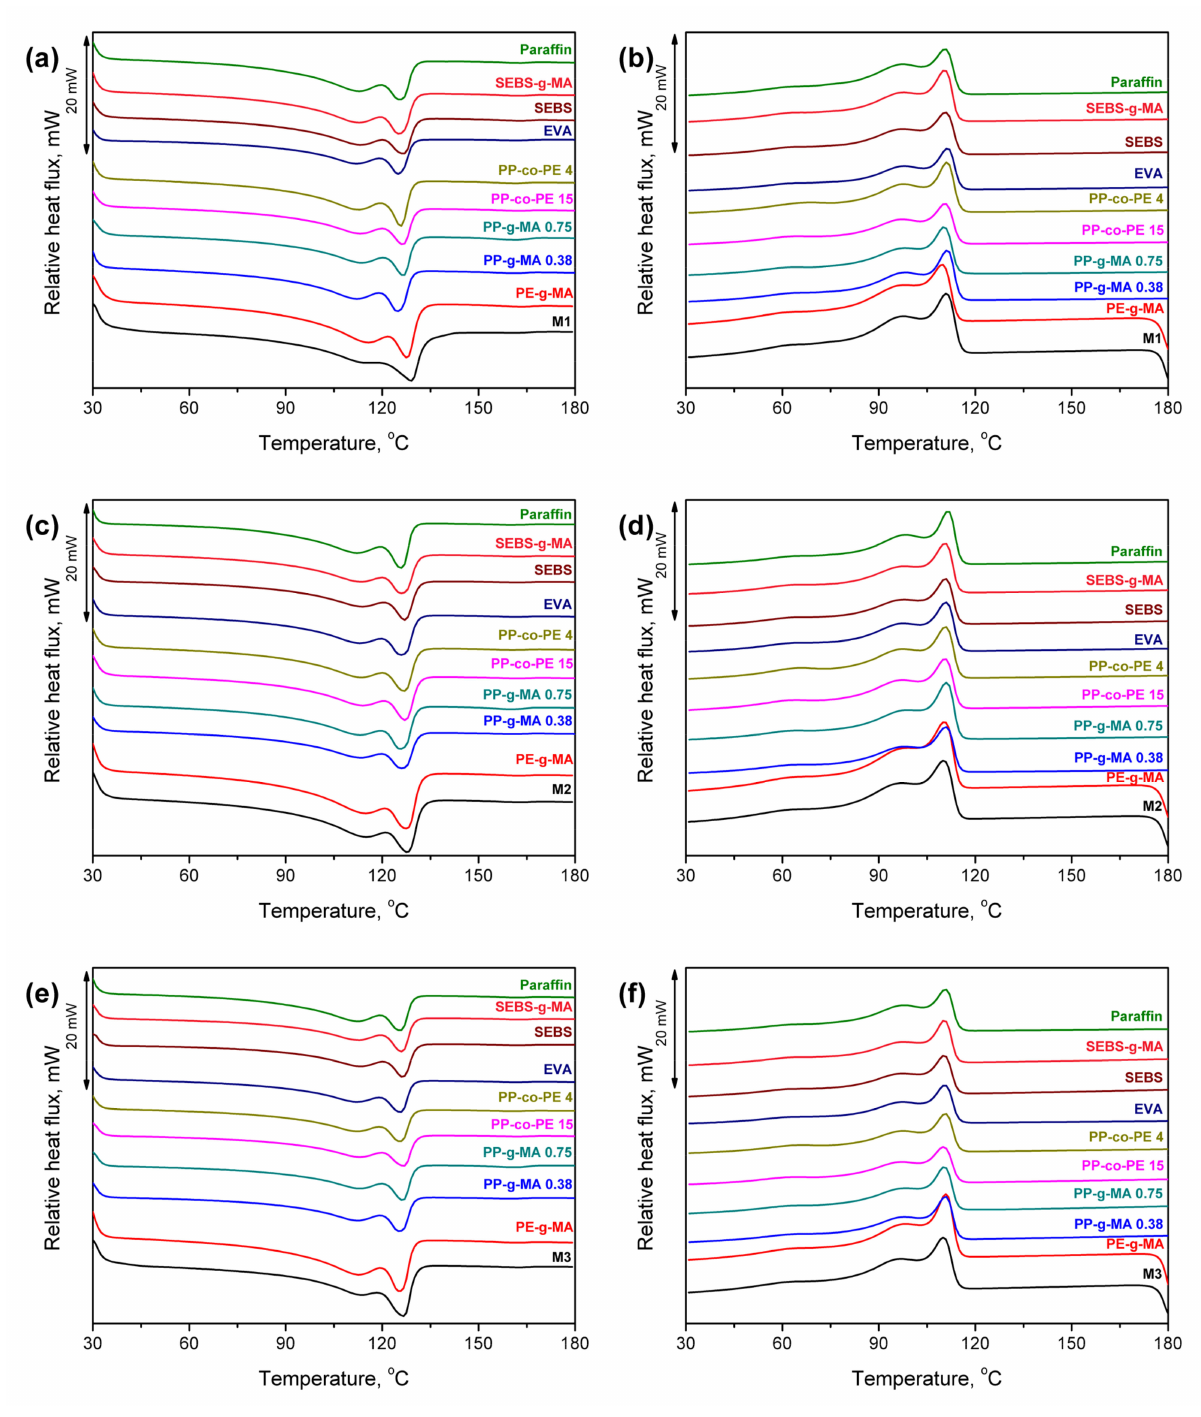
Figure 13. Differential scanning calorimetry thermograms (presented in “exo up” mode) for ( a , c , e ) heating and ( b , d , f ) cooling of compatibilized ( a , b ) M1, ( c , d ) M2 and ( e , f ) M3